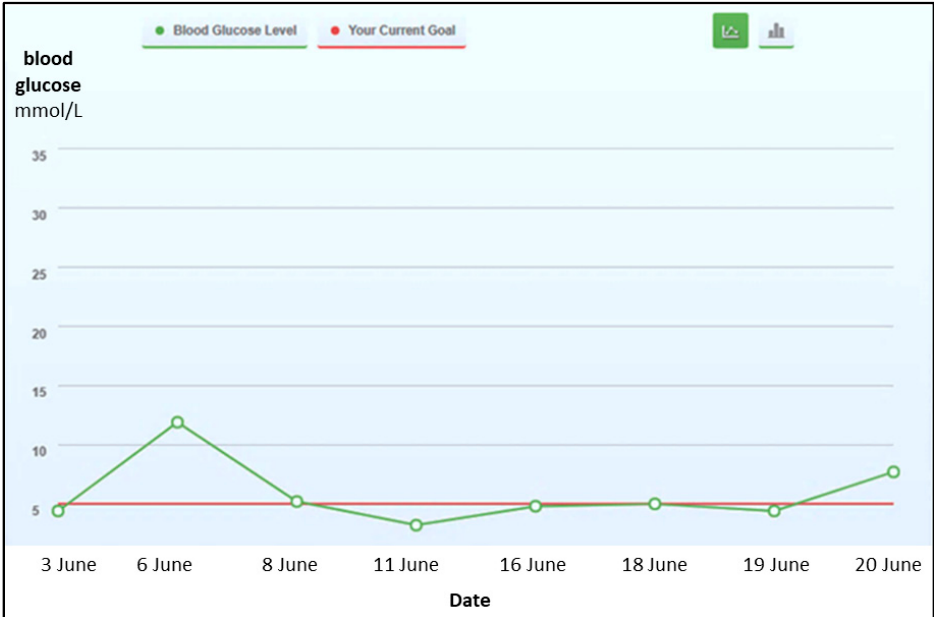
Figure 4. A line graph showing the actual blood glucose level and the desired blood glucose level (fasting blood glucose).